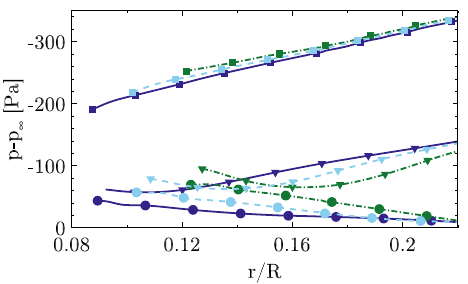
Figure 21. The effect of the nacelle thickness on radial pressure distribution on the suction side at x c /c ≈ 0 . 1 (squares), x c /c ≈ 0 . 5 (triangles) and x c /c ≈ 0 . 85 (circles) for CaseIsoRotor (dashed), CaseT1.0 (solid), CaseT1.4 (dashed